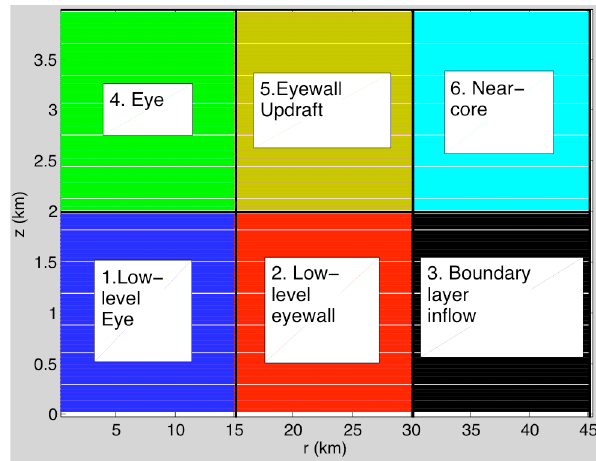
Fig. 2. Locations of boxes in the lower inner